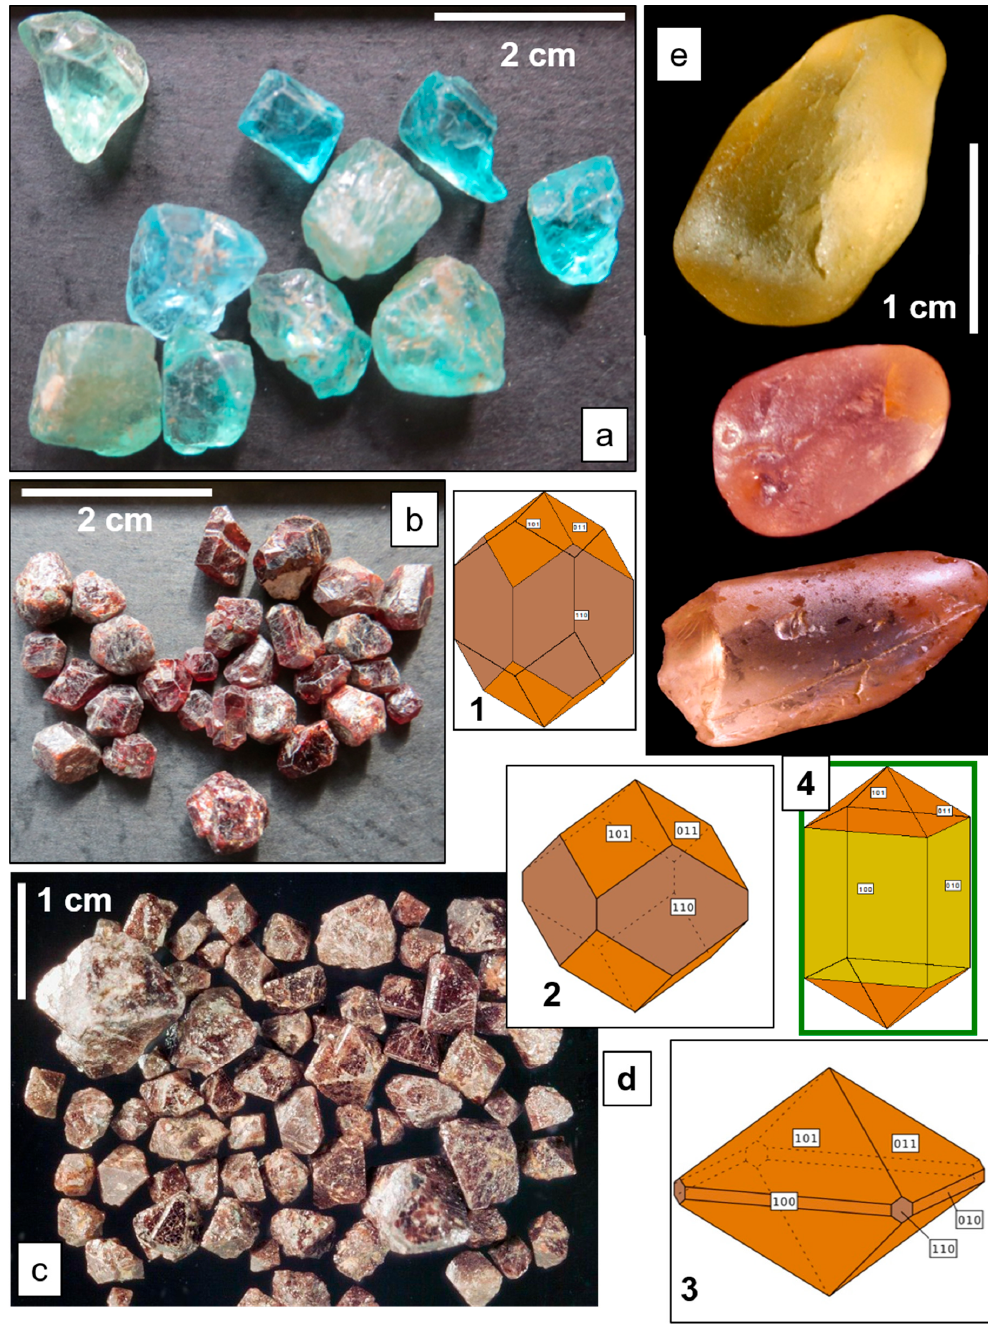
Figure 12. Apatite and zircon from placer deposits. ( a ) Greenish and blue apatite from alluvial placer deposits in Madagascar. ( b ) Brownish red translucent zircon from alluvial placer deposits in Madagascar. ( c ) Brown opaque zircon from alluvial placer deposits in SE Germany. ( d ) Crystal morphologies typical of zircon from pegmatitic deposits (1–3) and from their country rocks (4). ( e ) Pinkish and yellow well rounded zircon grains from an alluvial placer in SE Germany (photograph: B. Weber).